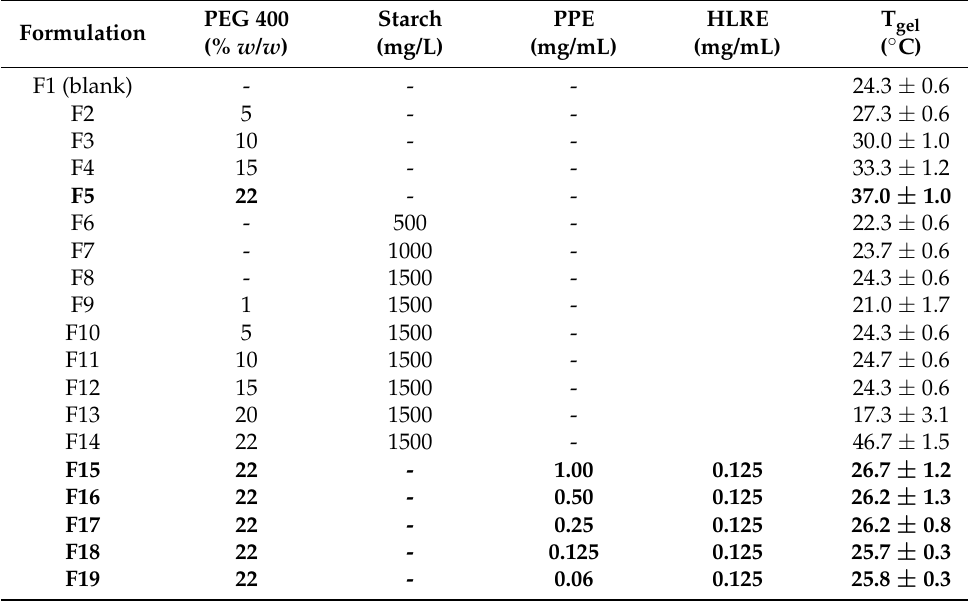
Table 3. T gel of thermoresponsive gels with different concentrations of PEG 400 and/or starch, and loading with HLRE and PPE, n =